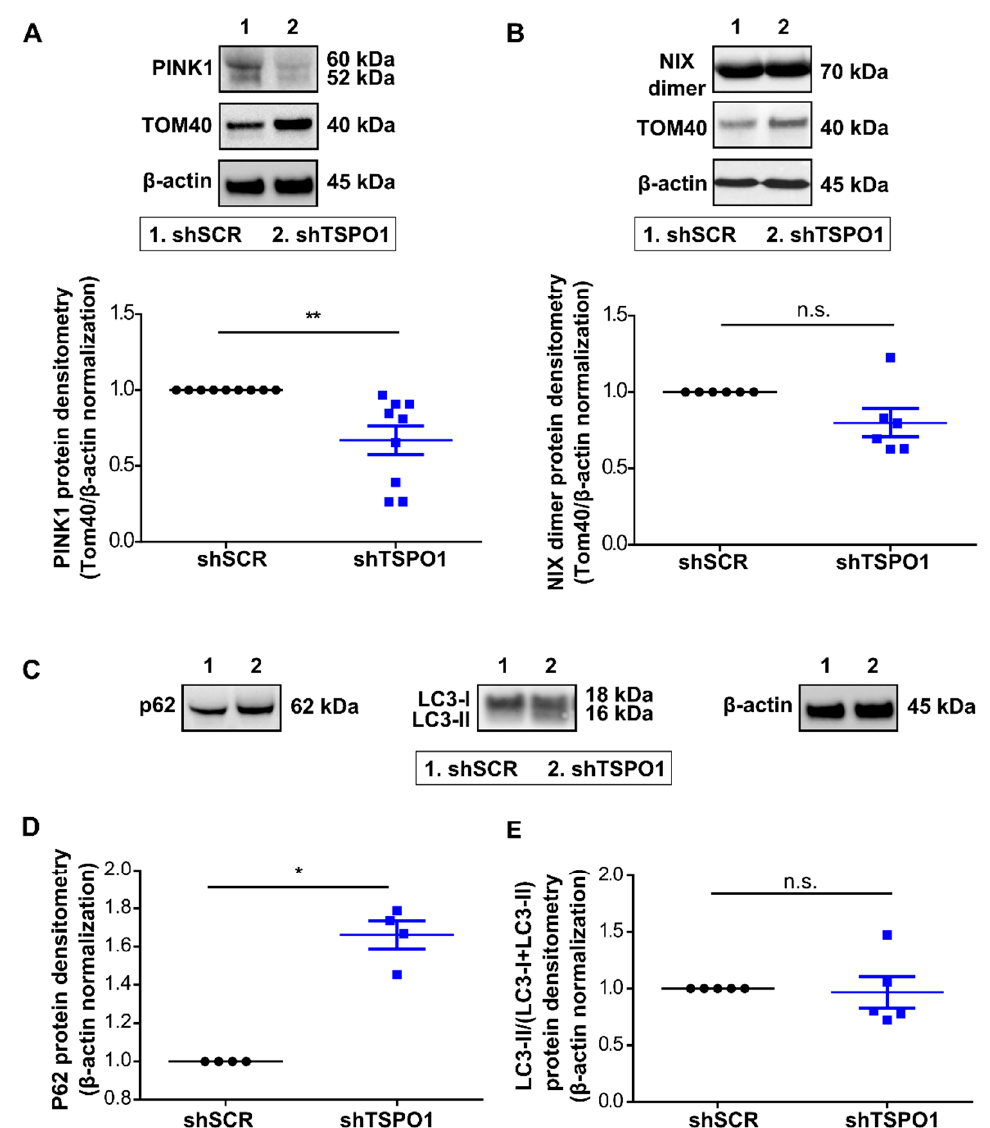
Figure 3. TSPO1 downregulation diminishes mitophagy-related protein levels. Western blot-based quantification of ( A ) PINK1 ( n = 9), ( B ) NIX ( n = 6), at Day 10 of differentiation normalized by quantity of mitochondria (TOM40) on total number of cells ( β -actin). Representative images ( C ) and Western blot-based quantification of ( D ) p62 and ( E ) LC3-II / LC3-I + LC3-II ratio. Levels in shSCR-transduced cells were arbitrarily set at “1”. * p < 0.05, ** p < 0.01, n.s. not statistically significant.